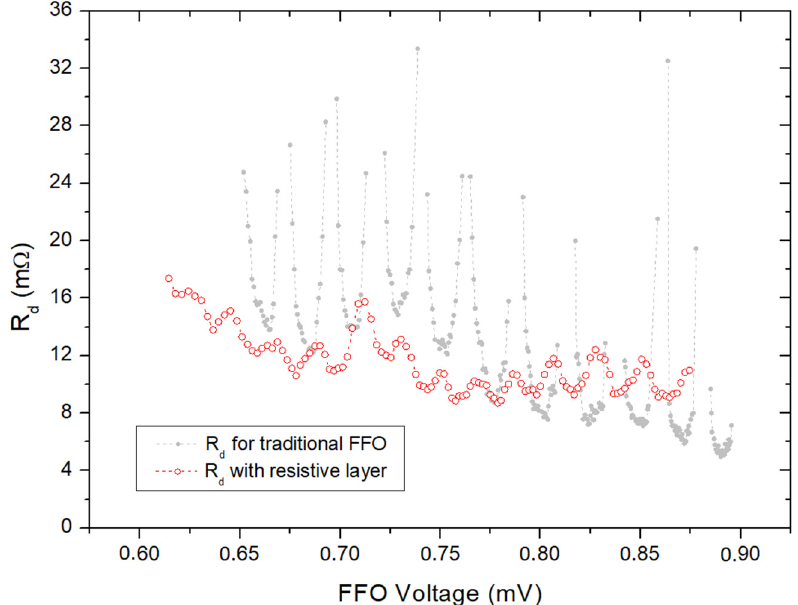
Figure 5. Comparison of the FFO differential resistance R d dependencies measured as a function of FFO voltage for two different FFO designs presented in Figure 3a,d; see also Figures 2c and 4c.